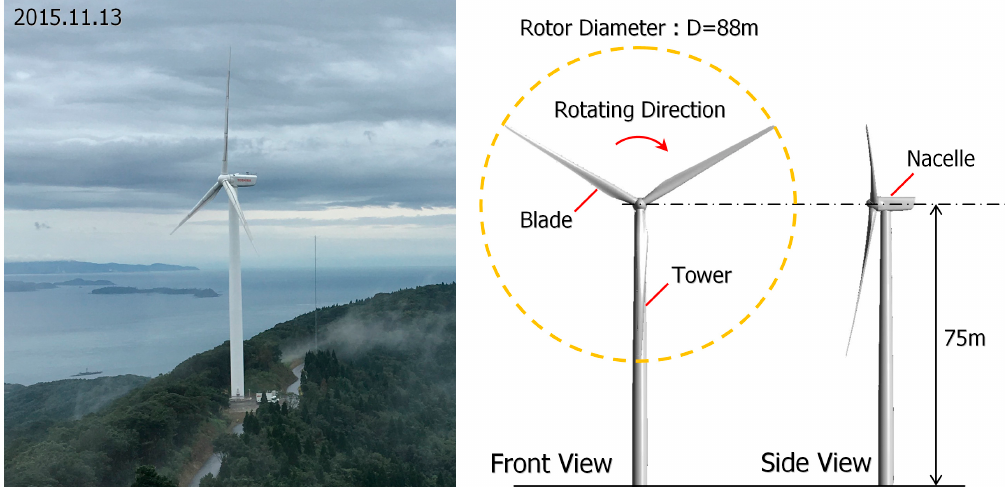
Energies 2019 , 12 , x FOR PEER REVIEW Figure 2. The 2-MW-large wind turbines studied in the present study. Figure 2. The 2-MW-large wind turbines studied in the present study.